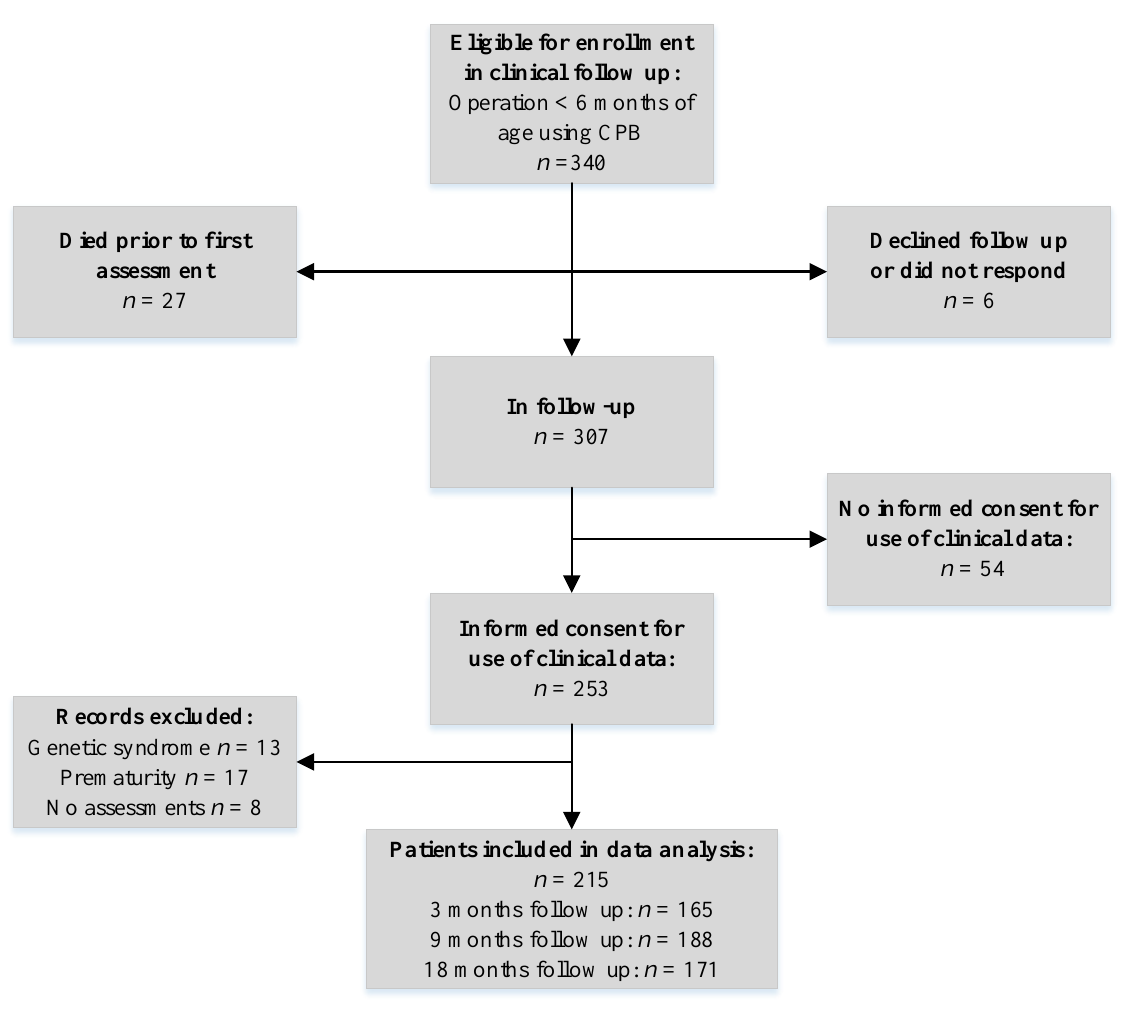
Figure 1. Enrollment flow